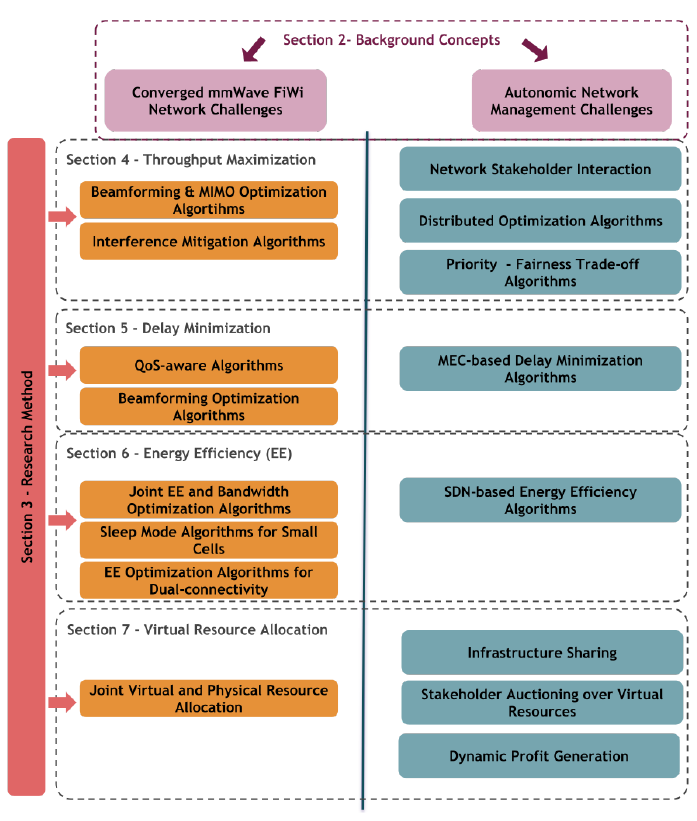
Figure 1. Sections of the review and highlighted concepts in selected